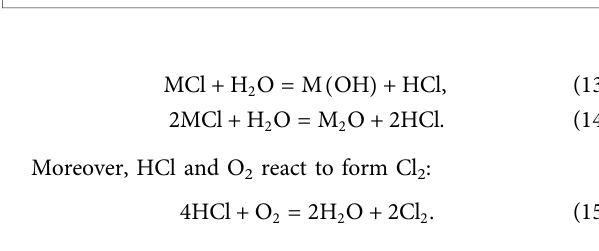
FIGURE 11 | The corrosion mechanism of the alloy in chloride salt